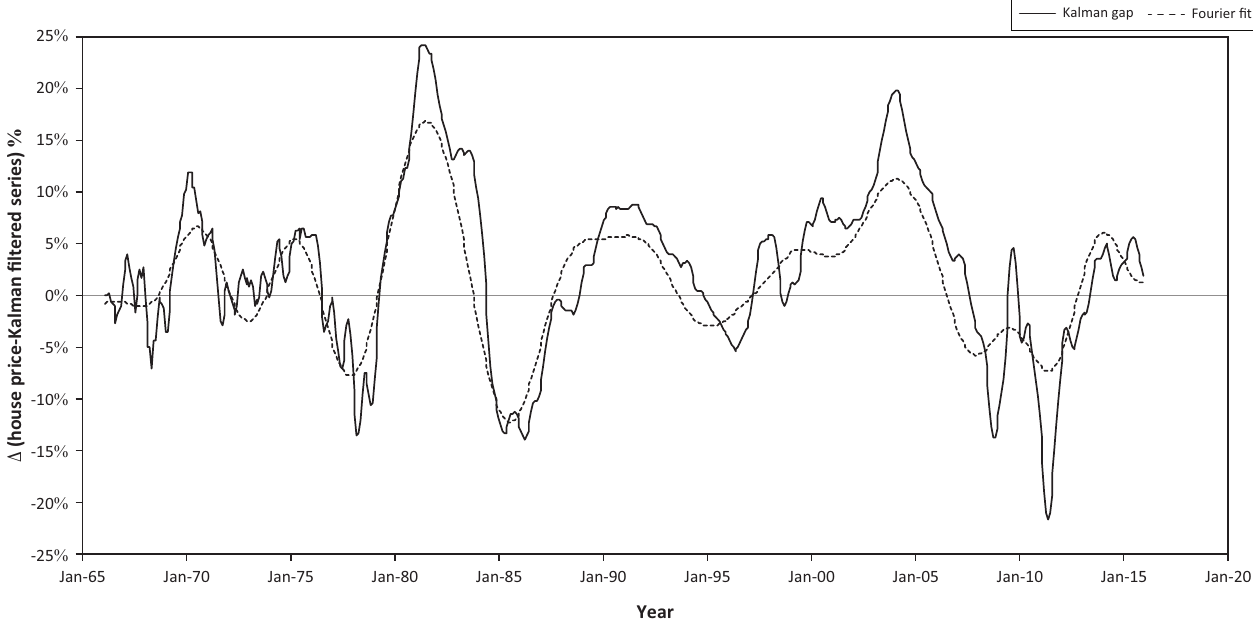
FIGURE 6: South African small residential price index gap and Fourier-fitted series.